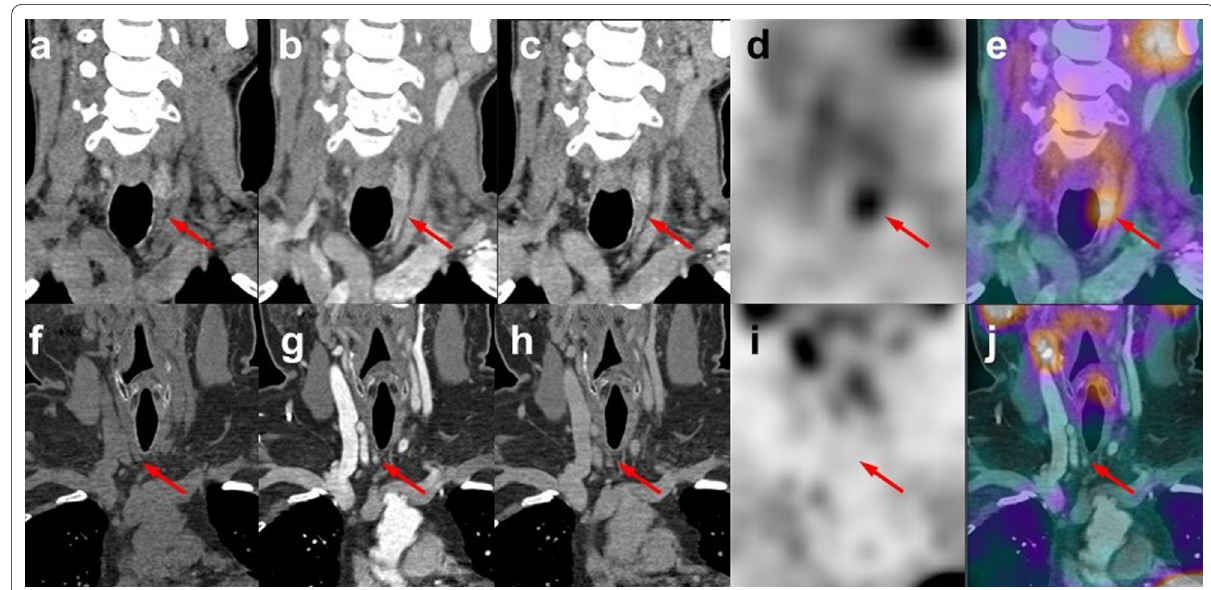
Fig. 6 Multiphase SPECT/CT coronal views for 2 patients, upper and lower rows, respectively. Native phase ( a and f ), arterial phase ( b and g ), venous phase ( c and h ) and 90 min Tc‑99m‑Sestamibi SPECT ( d and i ) and fused SPECT and arterial CT phase ( e and j ). Arrows point to the anatomical localisation of the parathyroid adenomas with a weight of 222 mg and 205 mg for the upper and the lower rows,